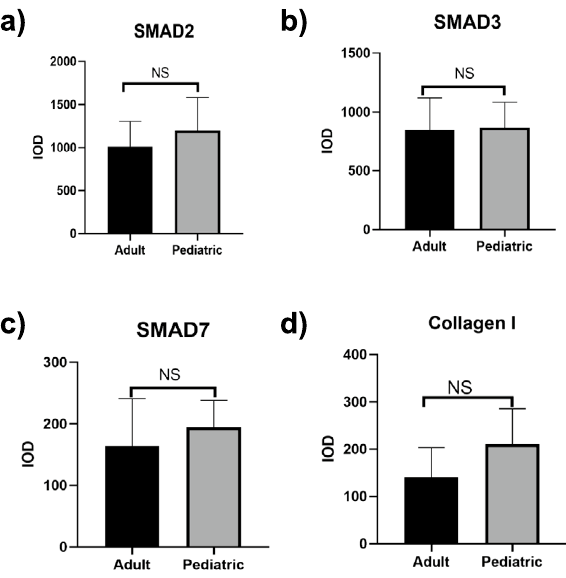
Figure 6. Comparison of expression levels of SMAD2, 3, 7, and type I collagen in adult and pediatric HOCM patients. ( a ) Comparison of the expression level of SMAD2 in adult and pediatric HOCM patients. Data are mean ± SEM, ns, non-significant, ( p > 0.05). ( b ) Comparison of the expression level of SMAD3 in adult and pediatric HOCM patients. Data are mean ± SEM, ns, non-significant, ( p > 0.05). ( c ) Comparison of the expression level of SMAD7 in adult and pediatric HOCM patients. Data are mean ± SEM, ns, non-significant, ( p > 0.05). ( d ) Comparison of the expression level of type I collagen in adult and pediatric HOCM patients. Data are mean ± SEM, ns, non-significant, ( p >